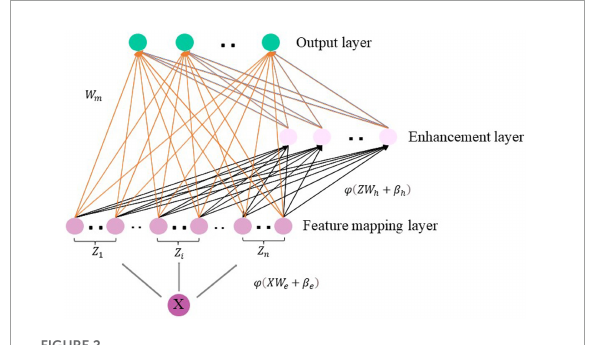
FIGURE2 The structure of the broad learning